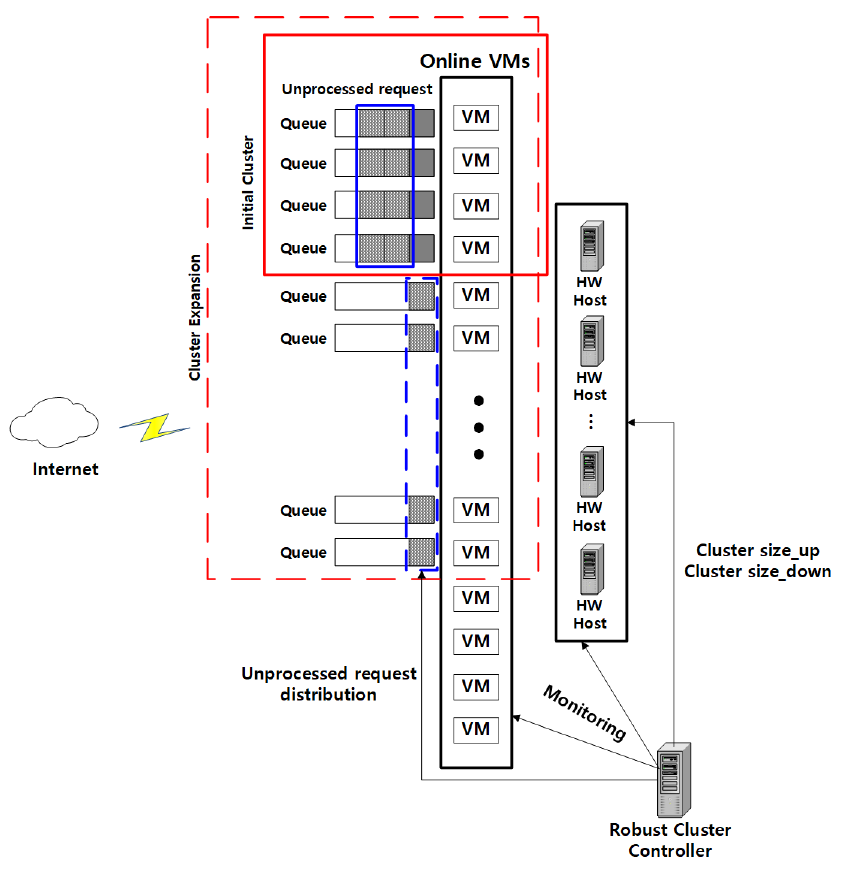
Figure 2. Architecture of the proposed scheme. HW: